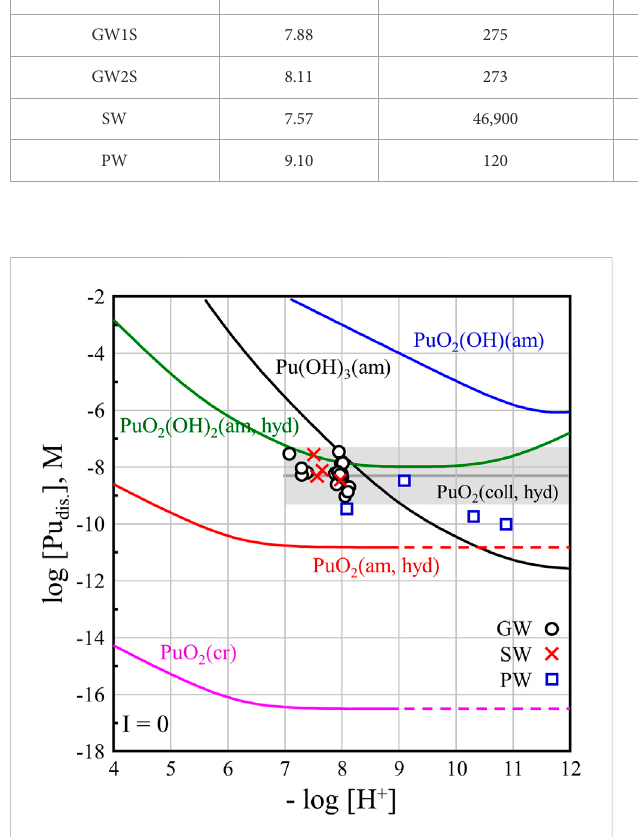
FIGURE 3 Solubility of PuO 2 (cr) powder in natural water (GW, SW, and PW) werecomparedwiththecalculatedsolubilitycurvesforhydroxideand oxide compounds of Pu(III-VI).